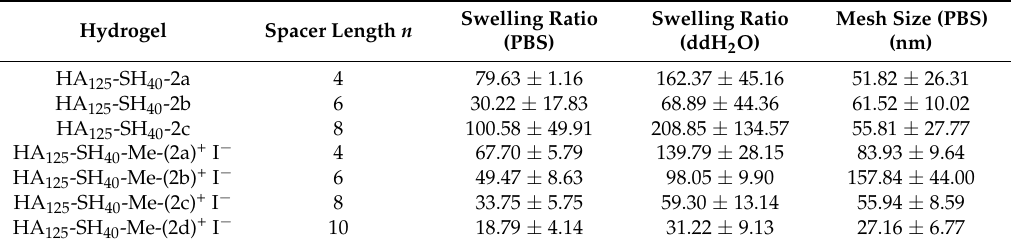
Table 2. Swelling ratios (wet weight/dry weight) and mesh sizes (in phosphate buffer solution (PBS)) of HA 125 -SH 40 - 2a–c and HA 125 -SH 40 - Me-(2a–d) + I − hydrogels. All values represent mean and standard deviation of three different experiments. ddH 2 O: double-distilled